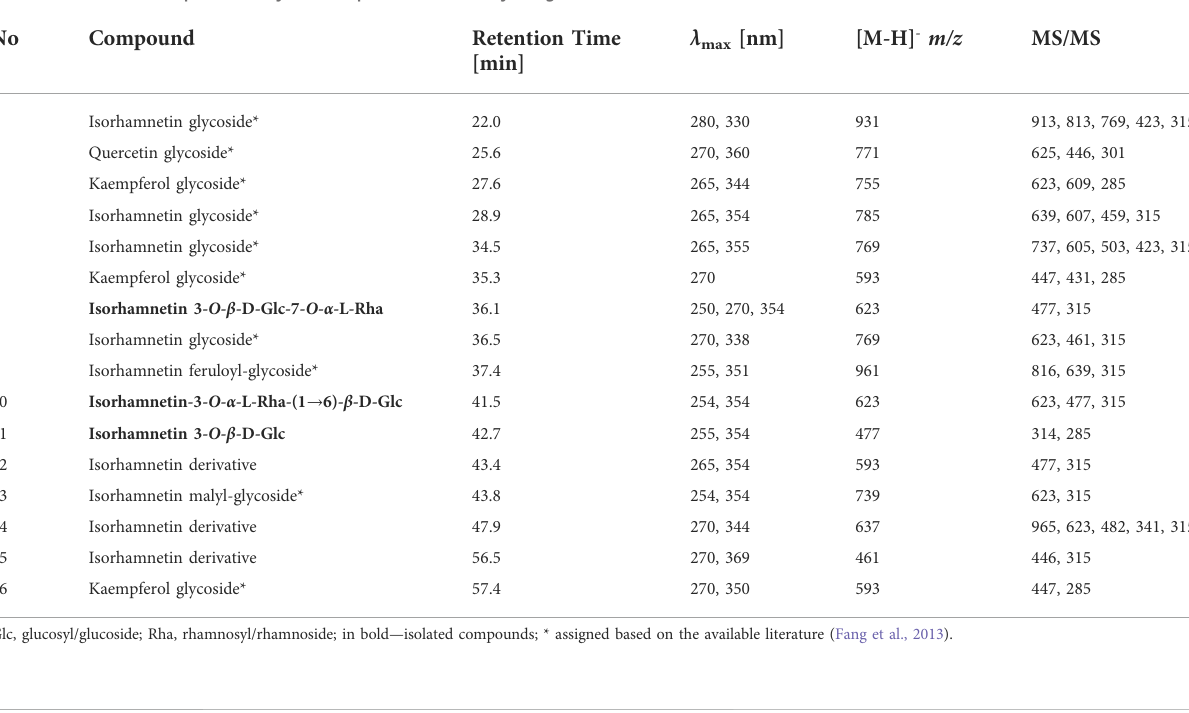
TABLE 1 Data of mass spectrometry for compounds tentatively assigned in HR.